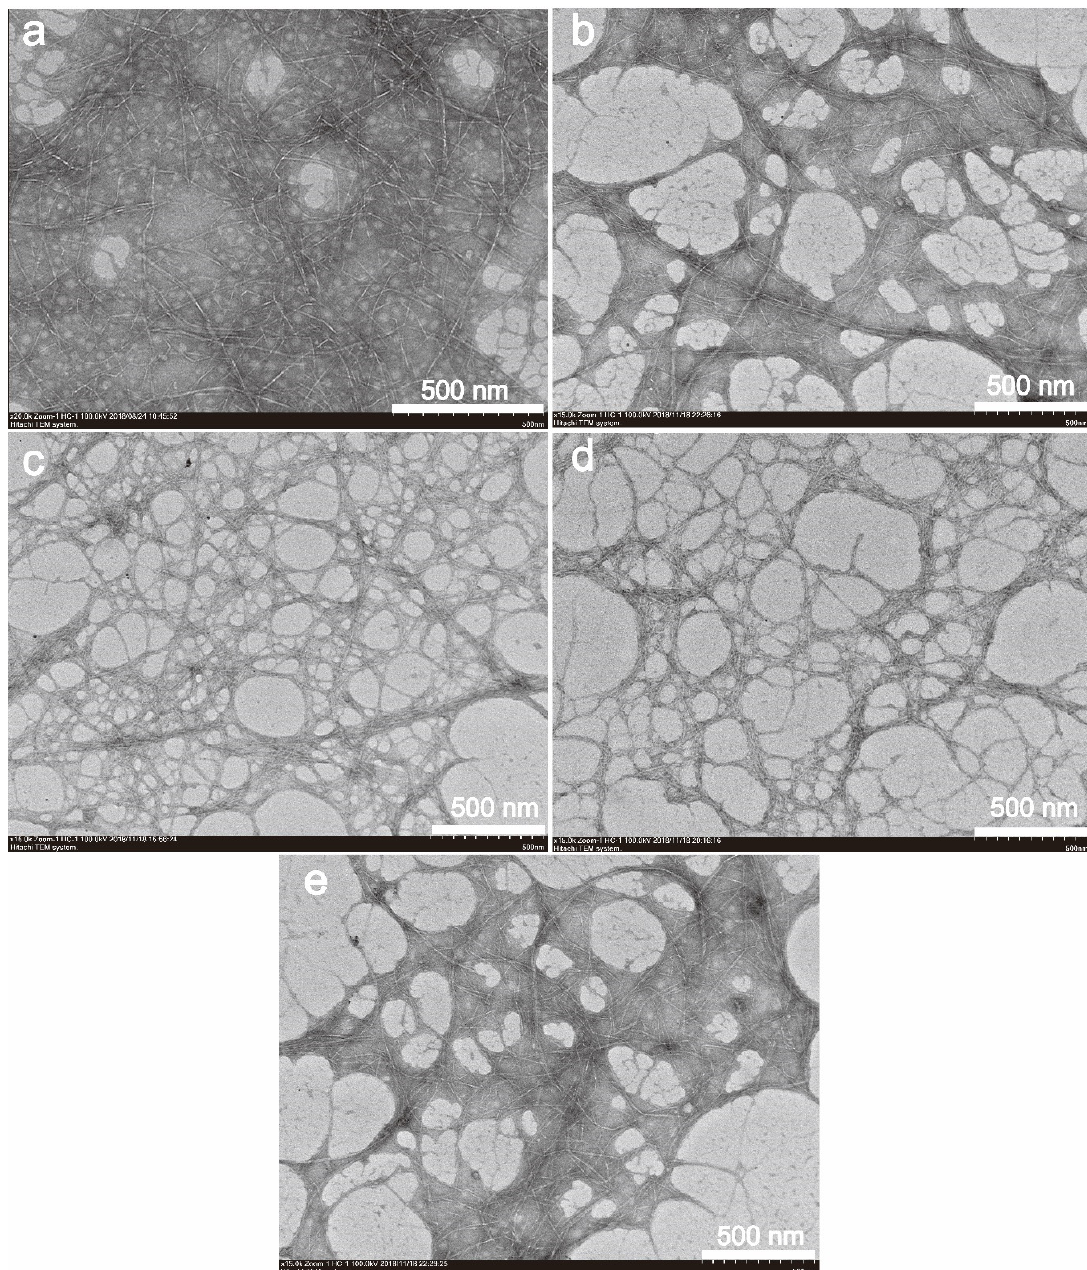
Figure 1. Transmission electron micrographs (TEM) of unmodified and modified cellulose nanofibril (CNF) samples: ( a ) CNF; ( b ) cross-linking (J)-CNF; ( c ) esterification (Z)-CNF; ( d ) J-Z-CNF; and ( e ) Z-J-CNF.